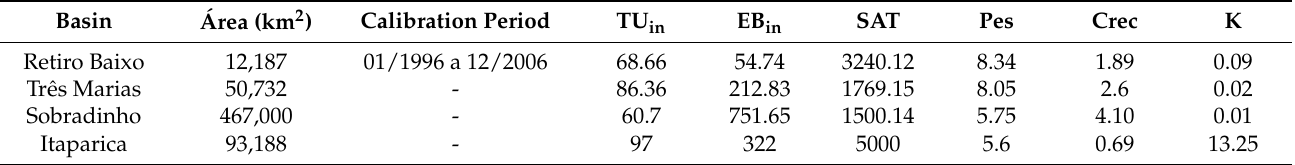
Table 2. SMAP parameters and initializations after calibration. Additionally, basin period and calibration